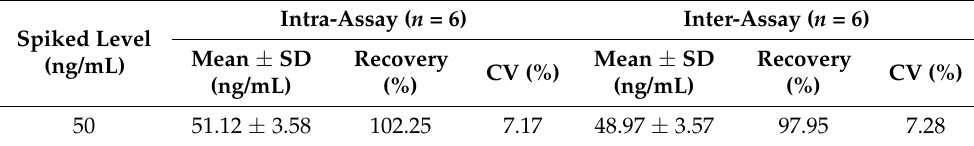
SD, standard deviation; CV, coefficient of